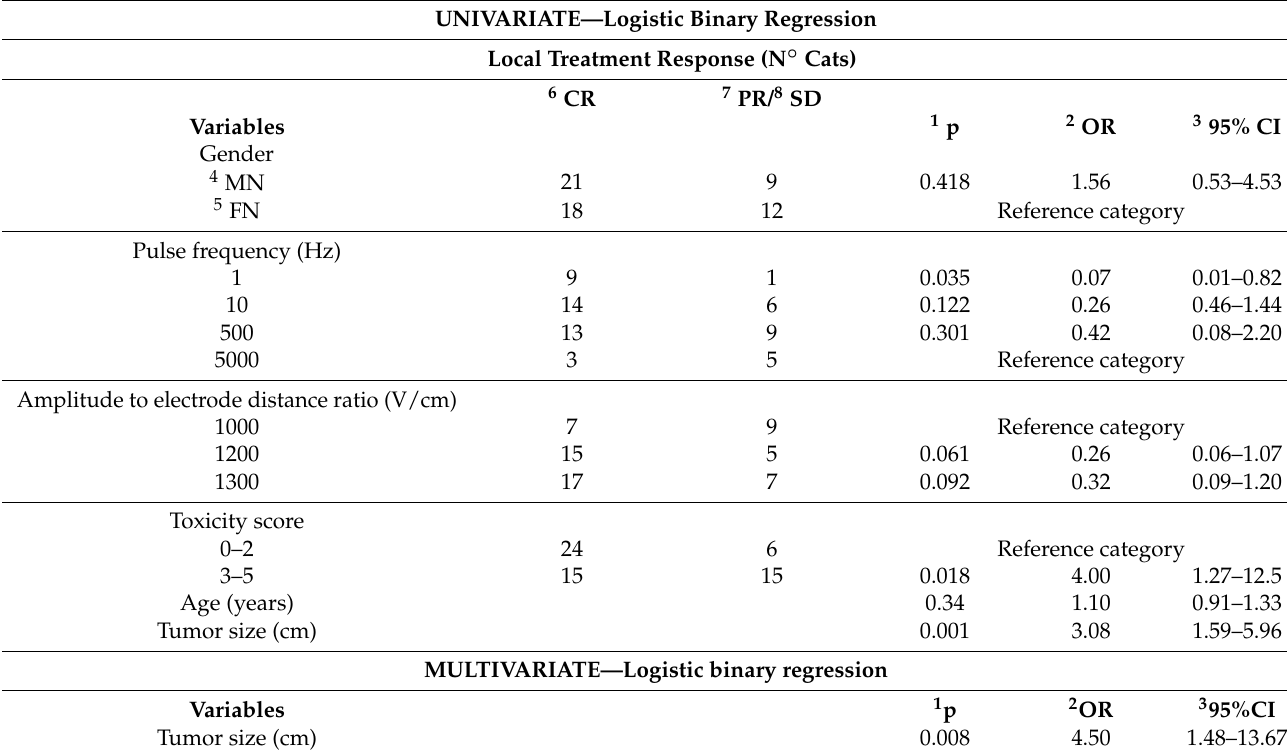
Table 4. Univariate and multivariate analyses for the relationship between variables and local treatment response. UNIVARIATE—Logistic Binary Regression